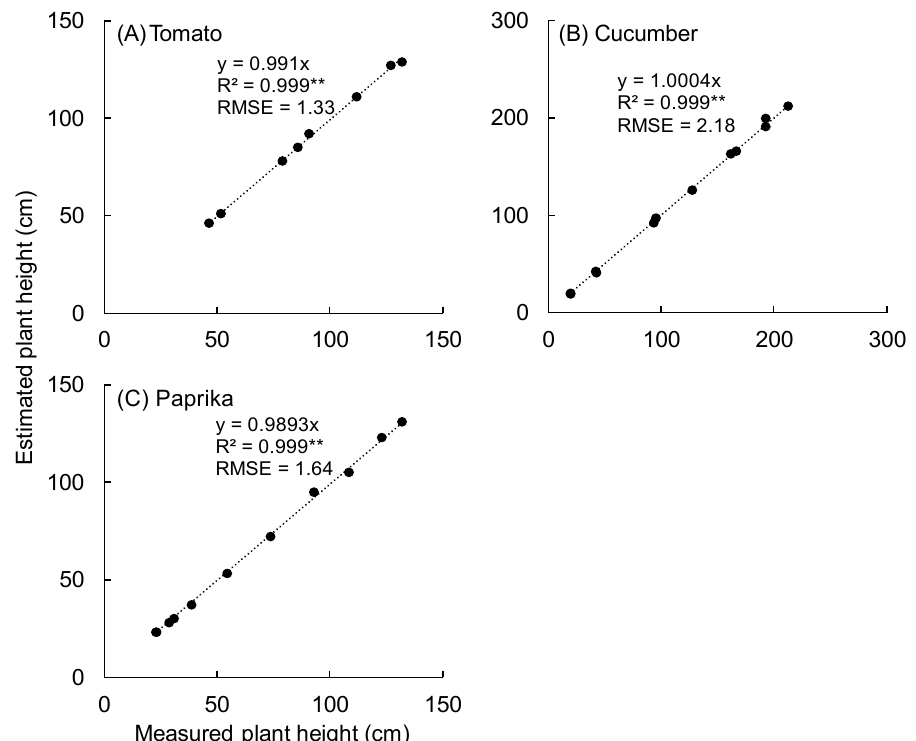
Figure 11. Relationship between measured plant height and estimated plant height. Plant height was estimated using the measuring tool in SketchUp 2017 (Trimble Inc., Sunnyvale, CA, USA). Tomato plants were scanned using the 3D scanner (DPI-8X, Opt Technologies Co., Ltd., Tokyo, Japan) from 5 April to 23 May 2019 ( A ). Cucumber plants were scanned from 3 April to 23 May 2019 ( B ). Paprika plants were scanned from 5 April to 2 August 2019 ( C ). ** significant at p < 0.01 according to the regression analysis. RMSE means root mean squared error. The canopy structures of tomato (49 DAT), cucumber (37 DAT), and paprika (107 DAT) obtained by the estimated leaf area at each height are shown in Figure 12.